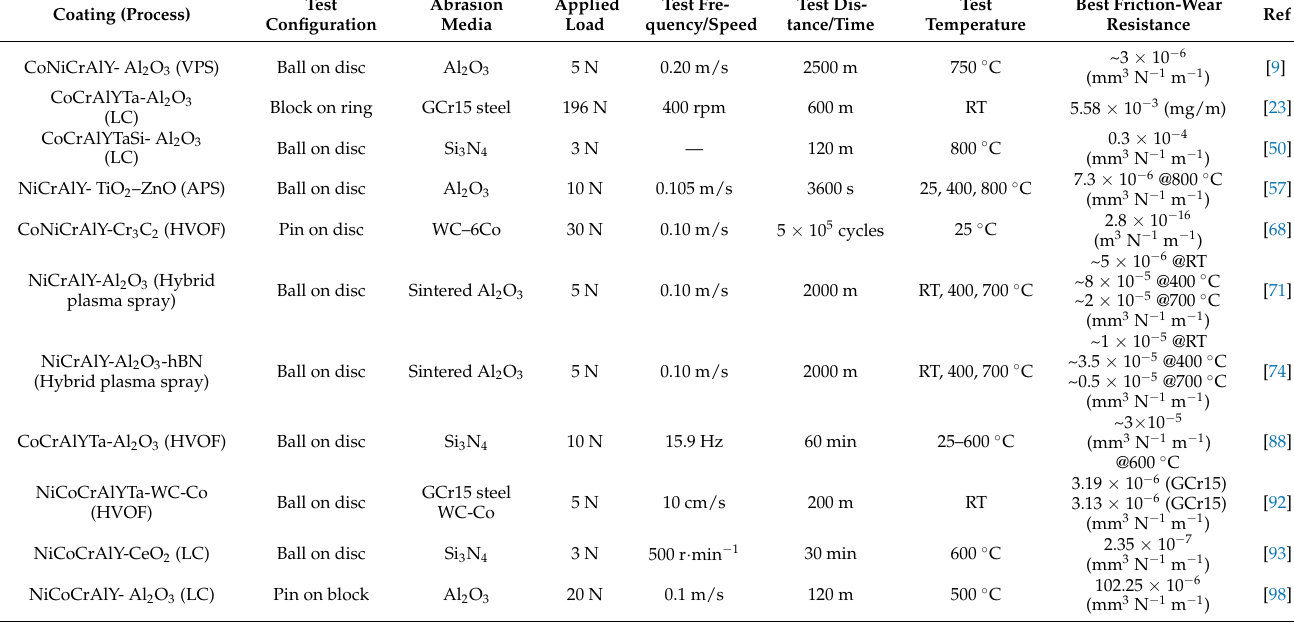
Table 4. Compilation of friction-wear studies on the dispersion strengthened MCrAlY